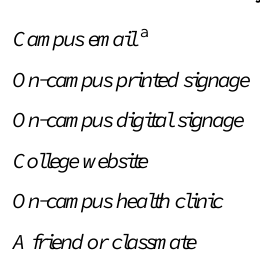
Table 5. Results of items on follow-up survey: data averaged across all programs (N=136). Awareness of service: How did you learn about Learn to